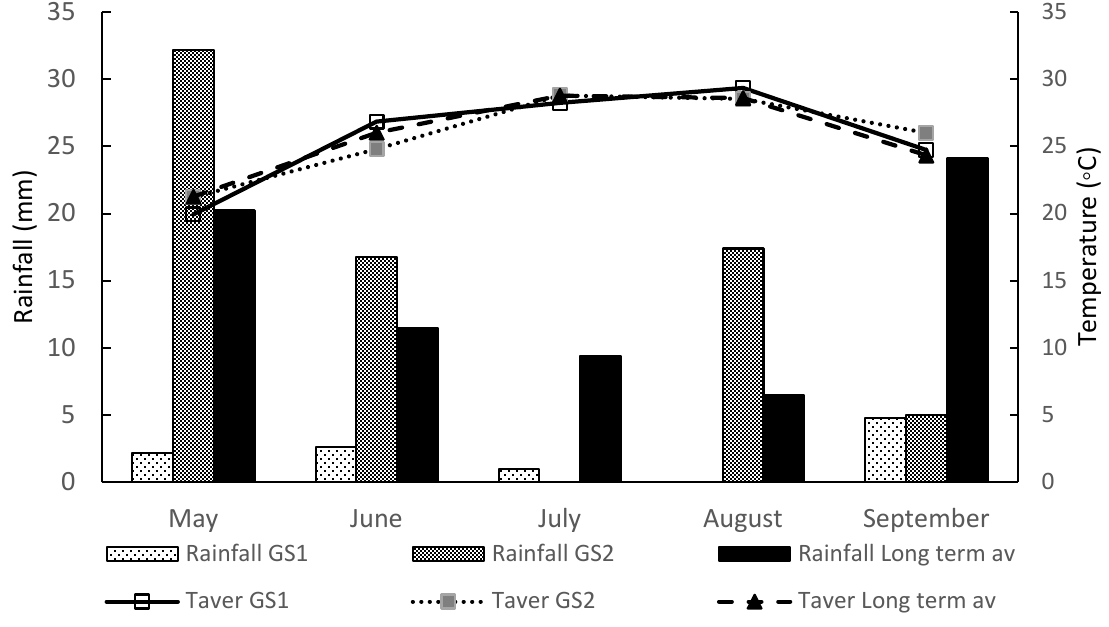
Figure 1. Monthly means of the mean (T aver ) air temperatures ( ◦ C) and total rainfall (mm) for 2019 (GS1), 2020 (GS2) growing seasons, and the long-term 30-year average (1989–2018) at the experimental site.